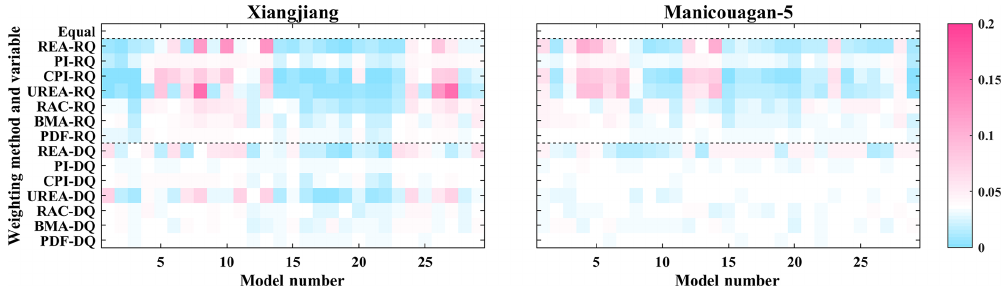
Figure 2. Weights assigned by equal weighting and seven unequal-weighting methods based on raw GCM-simulated streamflow ( RQ ) and bias-corrected GCM-simulated streamflow ( DQ ) for two watersheds. (Equal weight is presented in white; weights greater than equal are presented in red, and weights less than equal are represented in blue.) Table 3. The entropy of weights calculated by equal weighting and seven unequal-weighting methods based on raw GCM-simulated stream- flow ( RQ ) and bias-corrected GCM-simulated streamflow ( DQ ) for two watersheds. The entropy of weights calculated based on raw and bias-corrected temperature ( RT and DT ) and precipitation ( RP and DP ) are also presented for